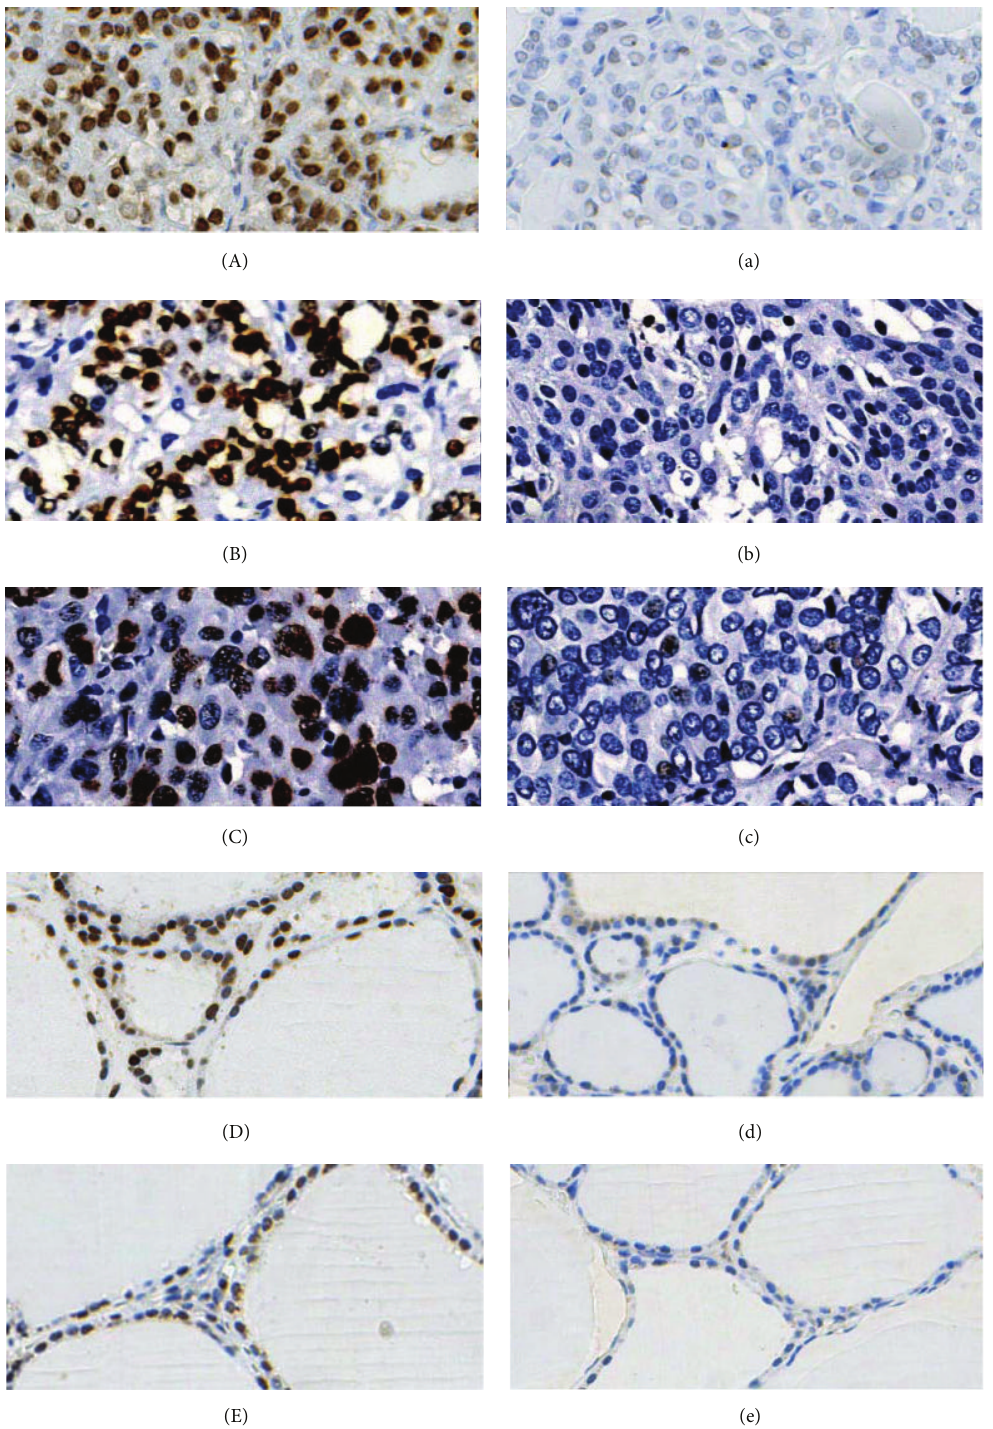
Figure 1: 𝛾 H2AX expression in thyroid tissues. (A) High expression of 𝛾 H2AX in well differentiated thyroid cancer. (a) Low expression of 𝛾 H2AX in well differentiated thyroid cancer. (B) High expression of 𝛾 H2AX in poorly differentiated thyroid cancer. (b) Low expression of 𝛾 H2AX in poorly differentiated thyroid cancer. (C) High expression of 𝛾 H2AX in anaplastic thyroid cancer. (c) Low expression of 𝛾 H2AX in anaplastic thyroid cancer. (D) High expression of 𝛾 H2AX in benign nodular goiter tissues. (d) Low expression of 𝛾 H2AX in benign nodular goiter tissues. (E) High expression of 𝛾 H2AX in normal adjacent tissues. (e) Low expression of 𝛾 H2AX in normal adjacent tissues. Original magnification of all images, ×